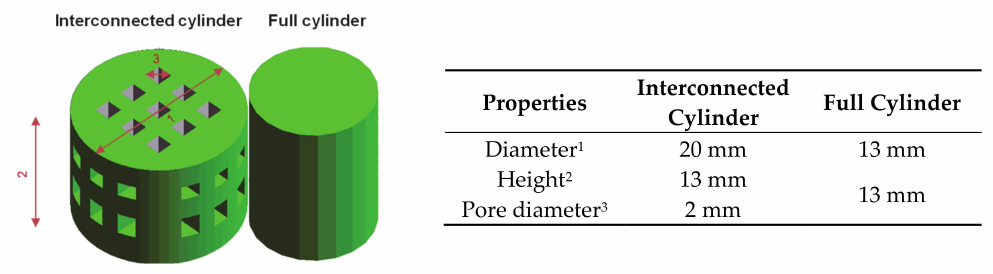
Figure 2. CAD Design and geometrical data of BaTiO 3 / HA composite sca ff